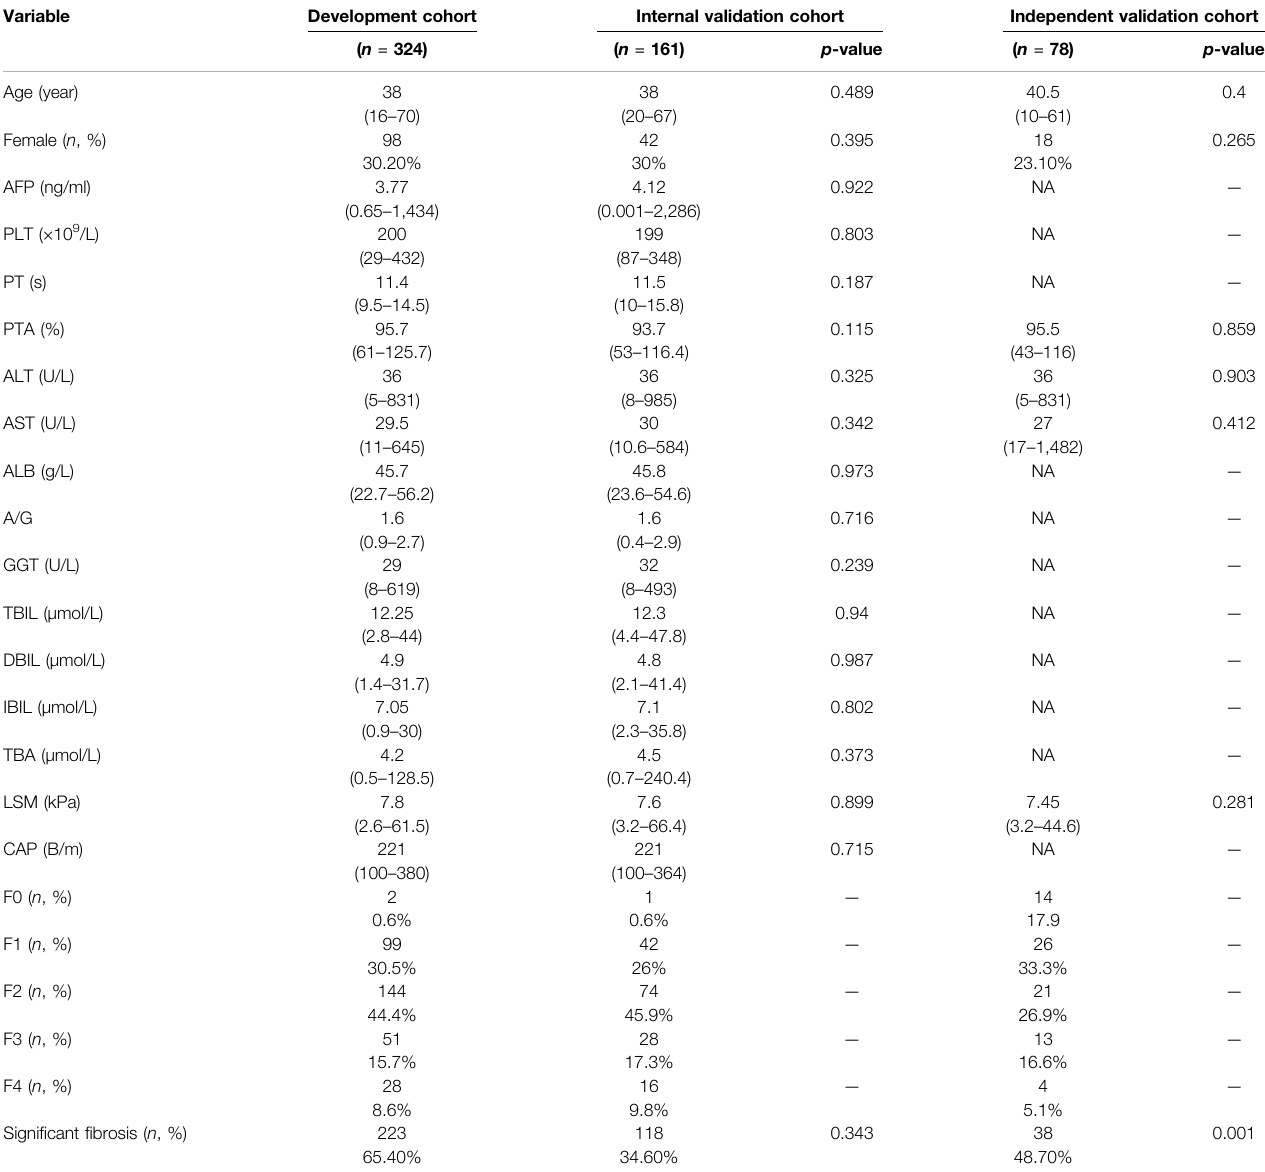
TABLE 1 | Baseline characteristics of patients in the development and validation